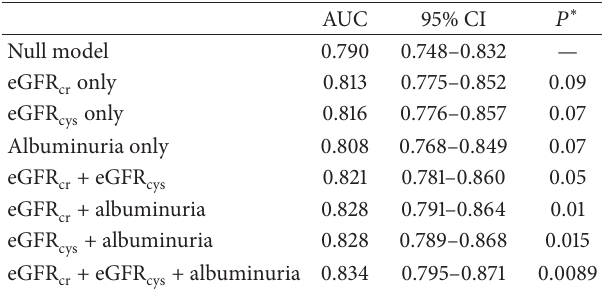
Table 3: Area under curve (AUC) for markers of CKD in isolation and in combination for discriminating persons with/without mod- erate DR. AUC